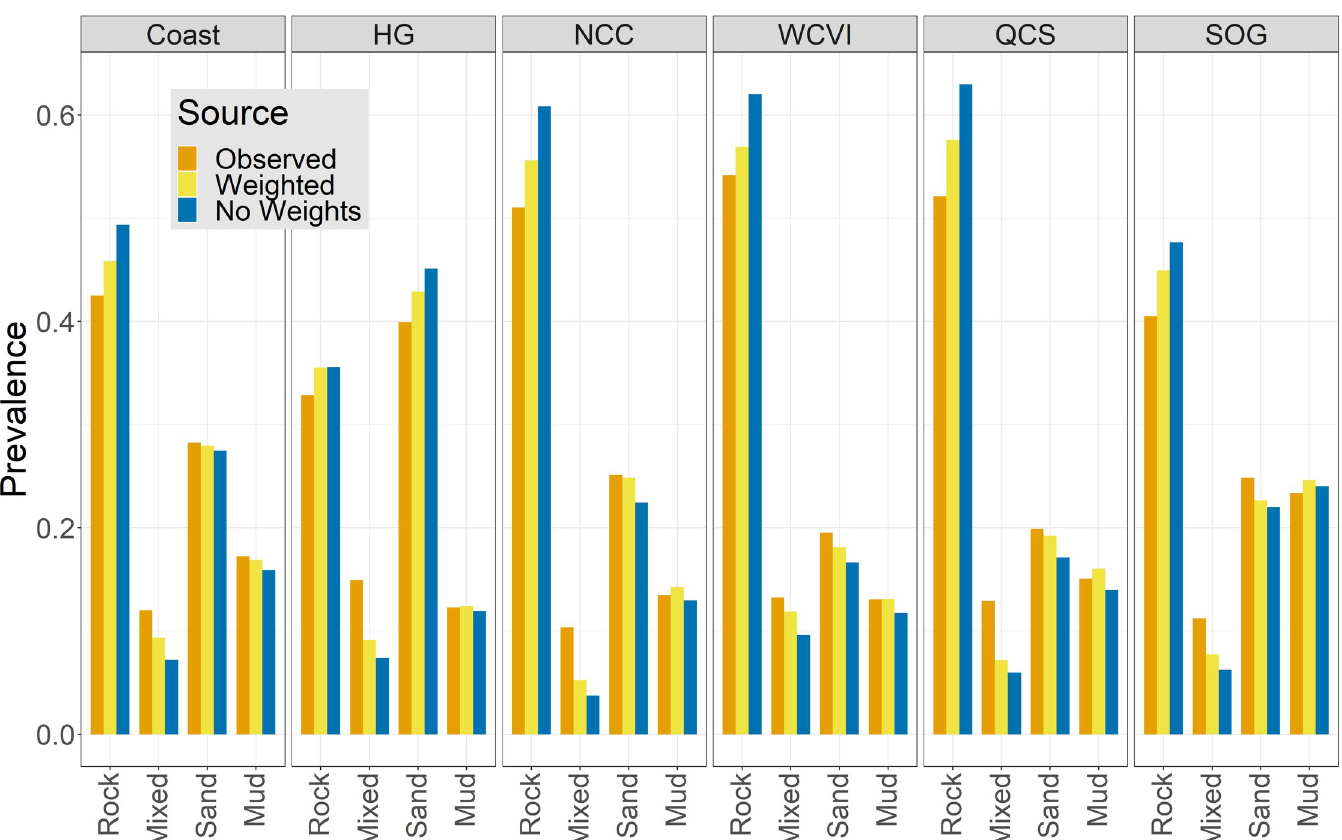
Fig 3. Comparison of class prevalence. Observed class prevalence in the build testing partition (orange) compared to predictions from the weighted (yellow) and unweighted (blue) random forest models across regions. Weighting tends to yield class prevalence closer to that observed in the build data (note that training and testing partitions have the same